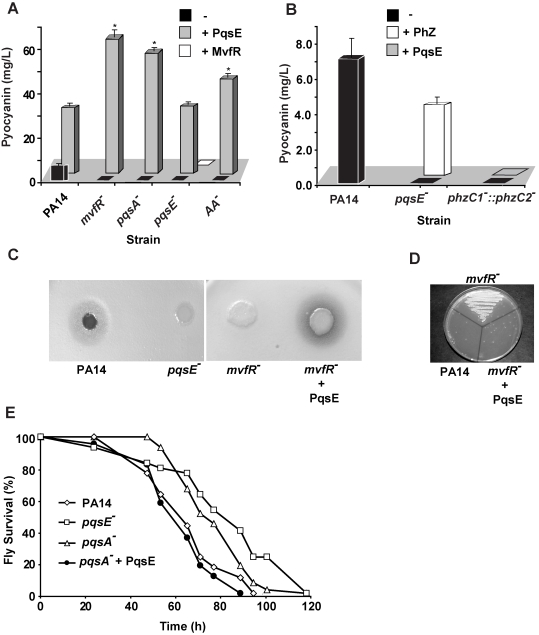
PqsE, a key mediator of the MvfR regulon activation, functions independently of AA and its derivatives.(A and B) Pyocyanin production was measured from PA14 and mutants with and without constitutive expression of PqsE or MvfR as a consequence of the presence of pDN19pqsE or pDN18mvfR plasmids, respectively. (A) AA− is a triple mutant with non-functional phnAB, trpE and kynBU that does not produce anthranilate. Production of pyocyanin (+ Phz) was achieved by co-culturing two sets of cells one constitutively expressing phzA2-G2, and the other phzM and phzS genes encoding the phenazines and pyocyanin biosynthetic genes respectively. Asterisks in A show strains harboring the plasmid pDN19pqsE that are significantly different (P value <0.01) from PA14 harboring that plasmid. (C–D) PqsE is essential for the virulence of P. aeruginosa against Cryptococcus neoformans independently of HAQs. PqsE was constitutively expressed in mvfR− mutant cells. An empty vector served as a control (−). (C) 1 µL of bacterial culture was spotted onto YPD top-agar where yeast cells were plated. Yeast killing zones were formed only around the PA14 and mutant cells expressing PqsE. (D) The death of yeast cells within the killing zone was demonstrated by assessing their viability on YPD plates. (E) PqsE causes fly mortality in absence of HAQs. Survival kinetics of Drosophila melanogaster was assessed using a fly feeding assay. The survival kinetics of pqsA
− and pqsE
− infected flies was significant different (P value <0.005) form that of PA14-infected flies. However, the kinetics of pqsA
− + PqsE- infected flies did not differ significantly from that of the PA14-infected flies(P value = 0.27).